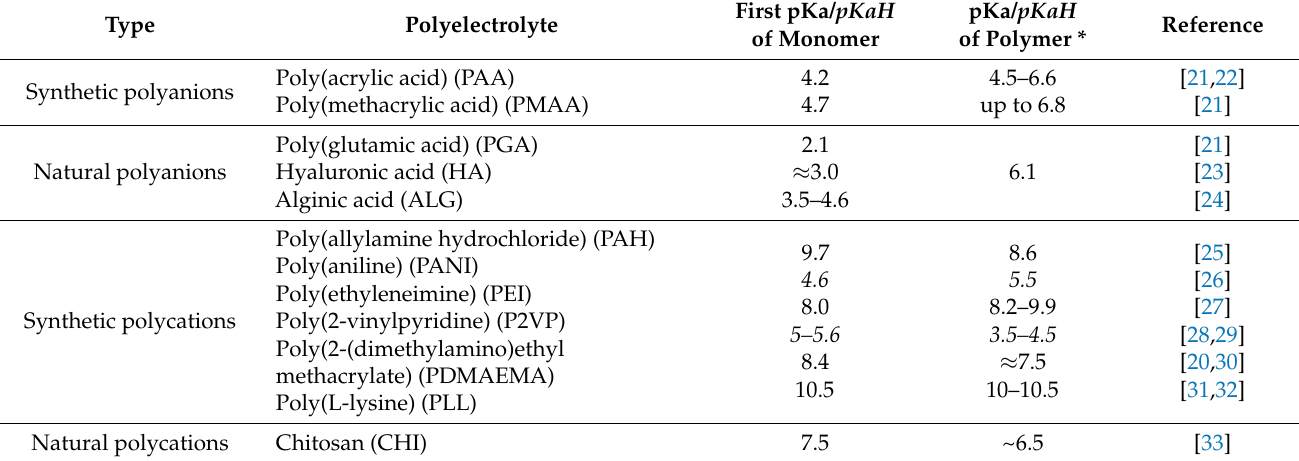
Table 1. Most common weak polyelectrolytes and their pKa/ pKaH . * When available, the apparent pKa/ pKaH of the polyelectrolyte is mentioned in parentheses. Note that these values may vary with the polyelectrolyte’s molecular weight and environment